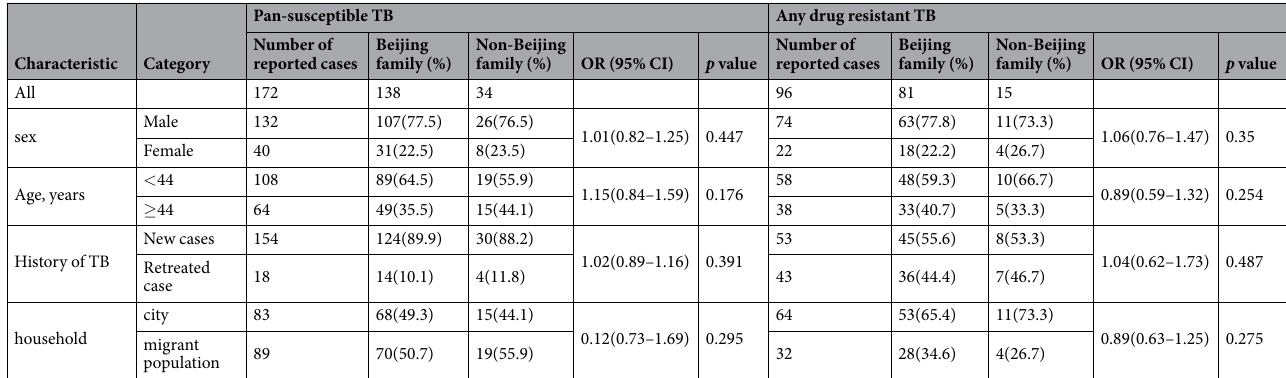
Table 5. The General demographic characteristics difference of Beijing genotype family and non-Beijing family patients among the pan-susceptible TB and any drug resistant TB. p value indicates whether there is a significant difference between Beijing family and non-Beijing family. ( p < 0.05 represents a statistically significant